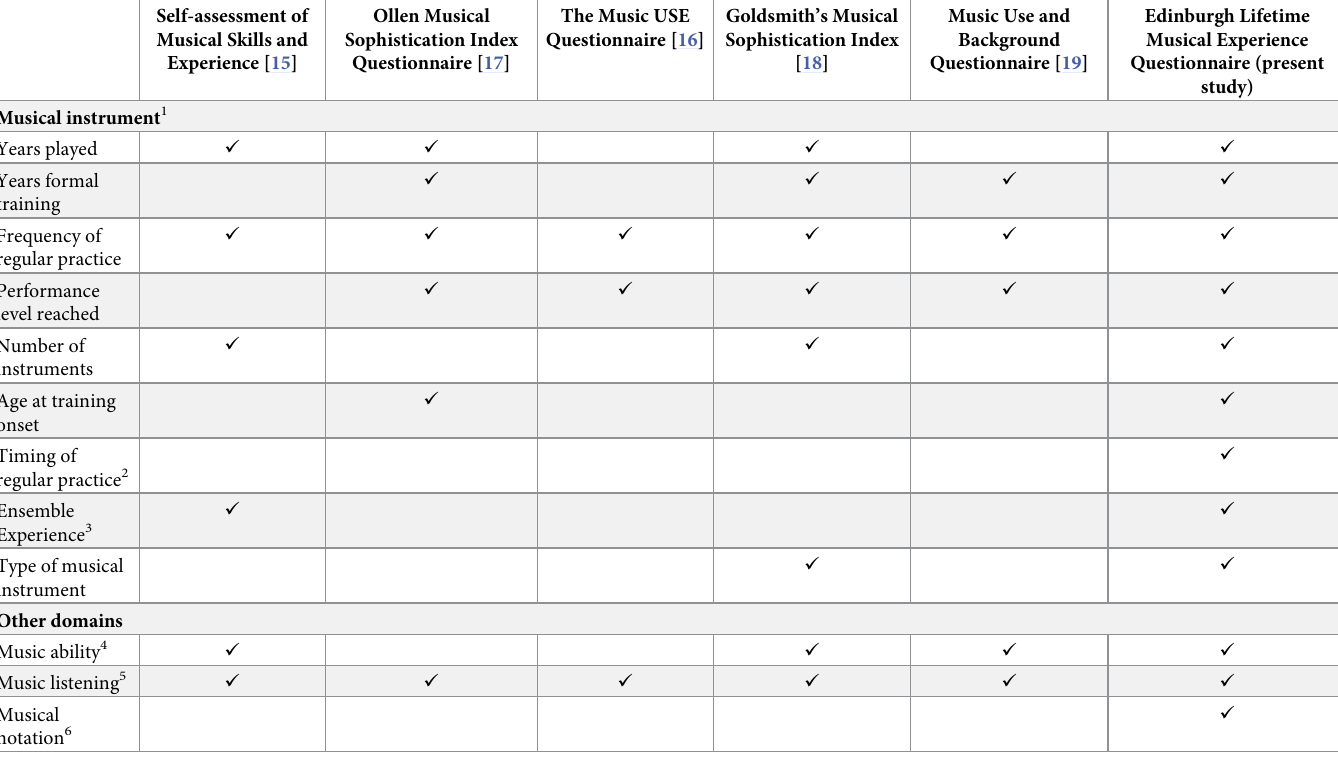
Table 1. Self-report questionnaires of musical training and